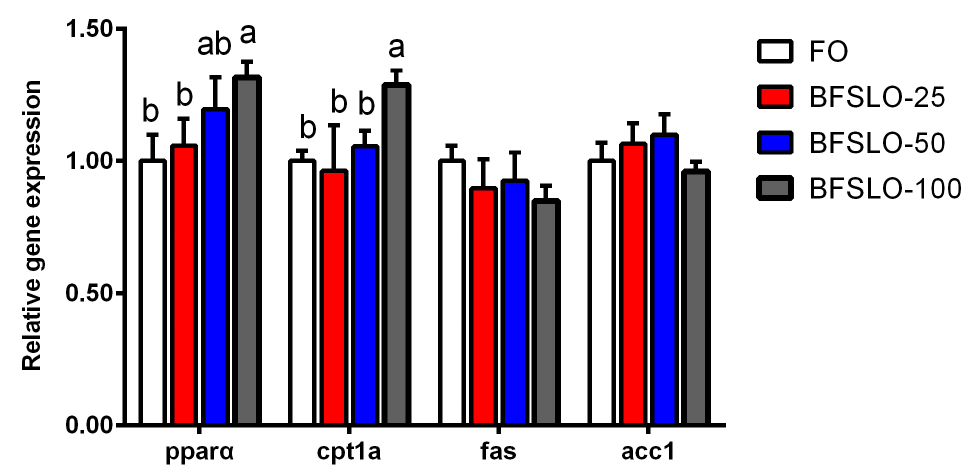
Figure 2. The relative expression of genes involved in lipid metabolism of intraperitoneal fat in O. macrolepis fed the four experimental diets with different gradient levels of BSFLO (25%, 50% and 100%) replacing FO (control) for eight weeks. Data are expressed as mean and SEM. Values with different superscripts (a, b, ab) in the same column are significantly different (one-way ANOVO) ( p < 0.05). pparα, peroxisome proliferators-activated receptor alpha. cpt1a, carnitine palmitoyltrans- ferase 1 isoform a. fas, fatty acid synthase. acc1, acetyl-CoA carboxylase 1.